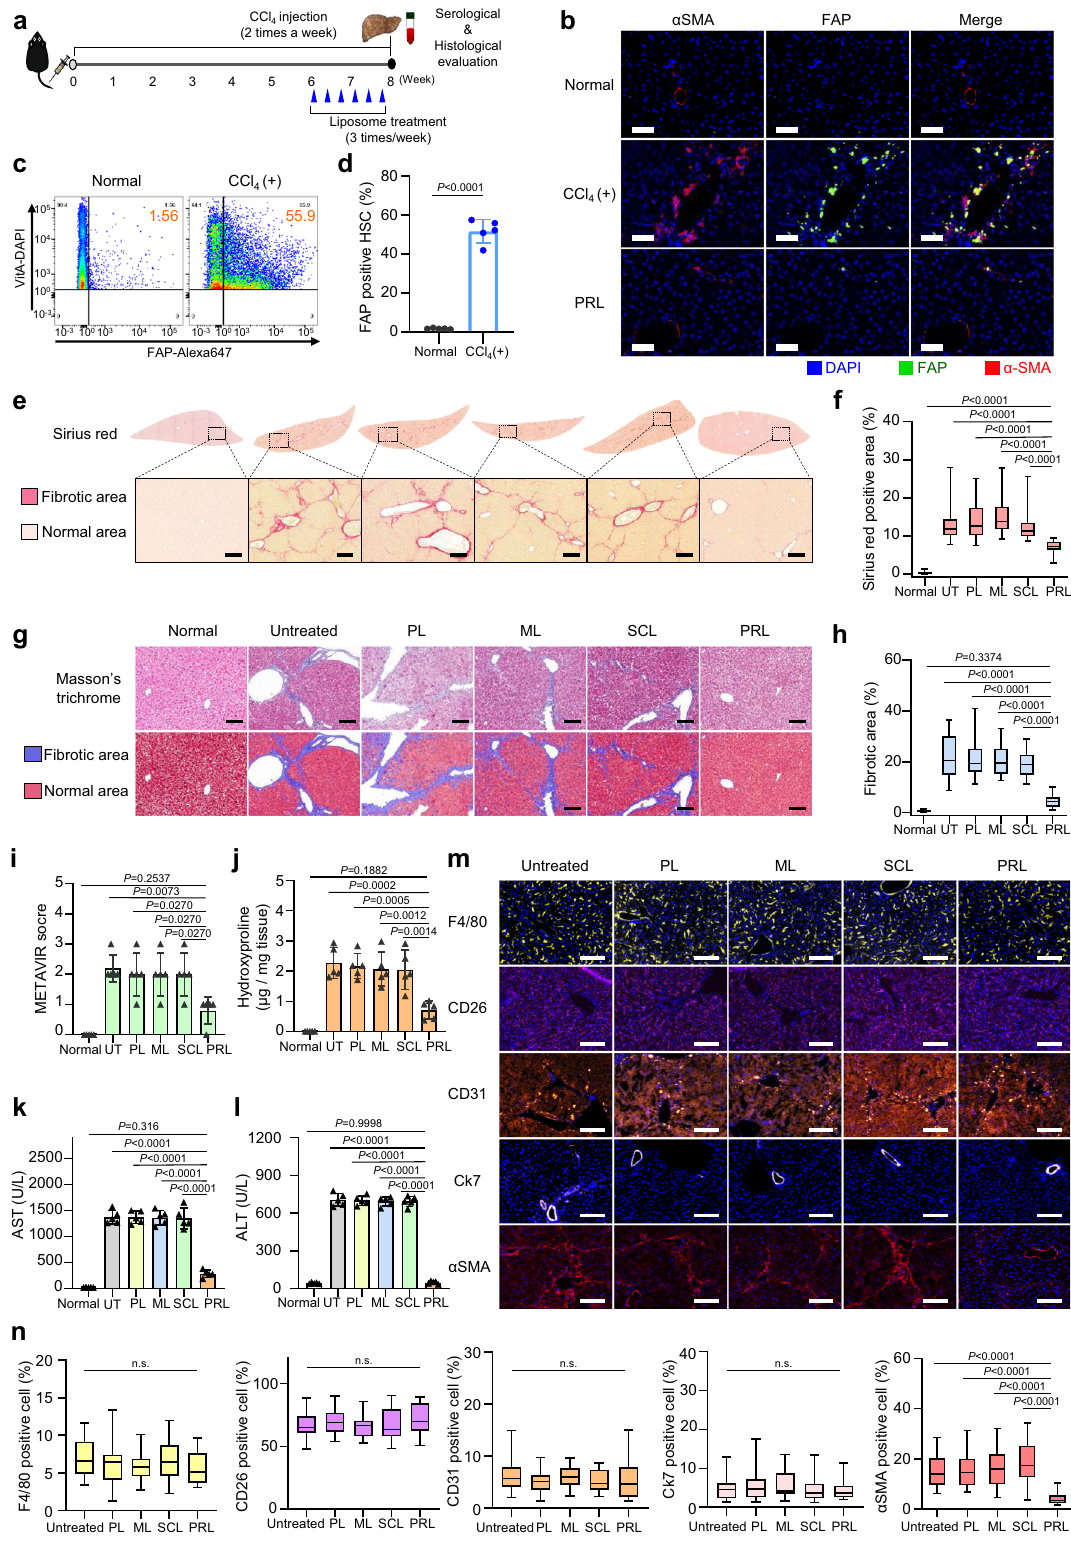
Our molecular imaging studies revealed that the activation of PRL was speci fi c to the liver of BDL model mice, and was not seen in other organs. The notable fl uorescence intensities of FQL at the liver of BDL model mice supports the notion that the fl uorescent signal is selectively liberated by the increased FAP expression in liver tissues of BDL model mice. We